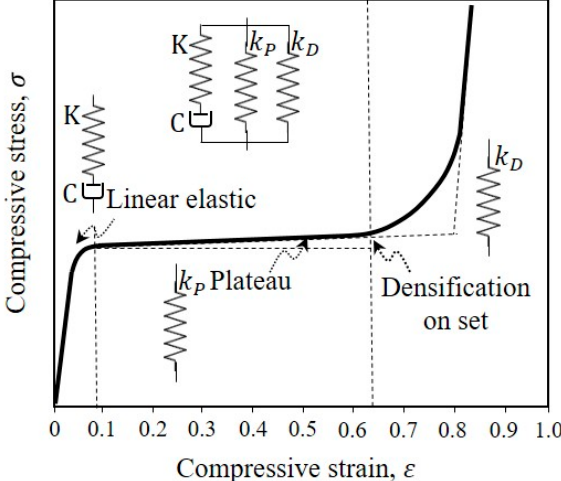
Figure 4. Schematic stress–strain curve showing elastic, plateau, and densification regions during compression of a polymeric foam and the phenomenological foam (PF) model proposed by Alzoubi et al. [19].